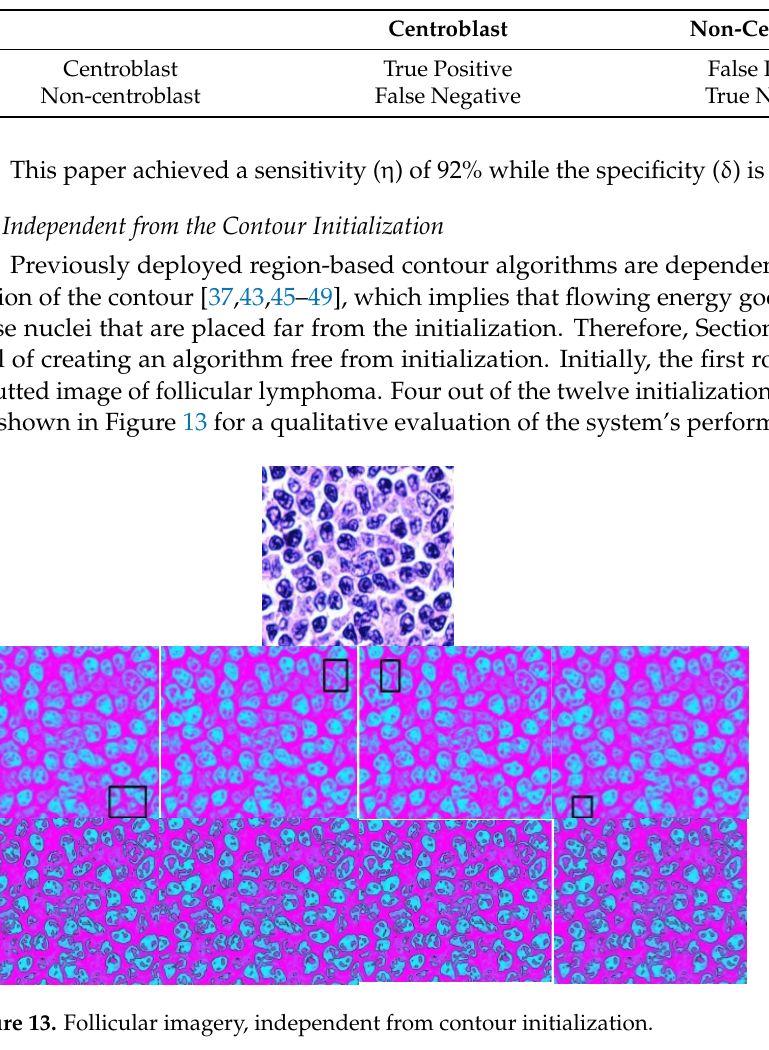
Table 5. Confusion matrix to elaborate accuracy of the proposed methodology.